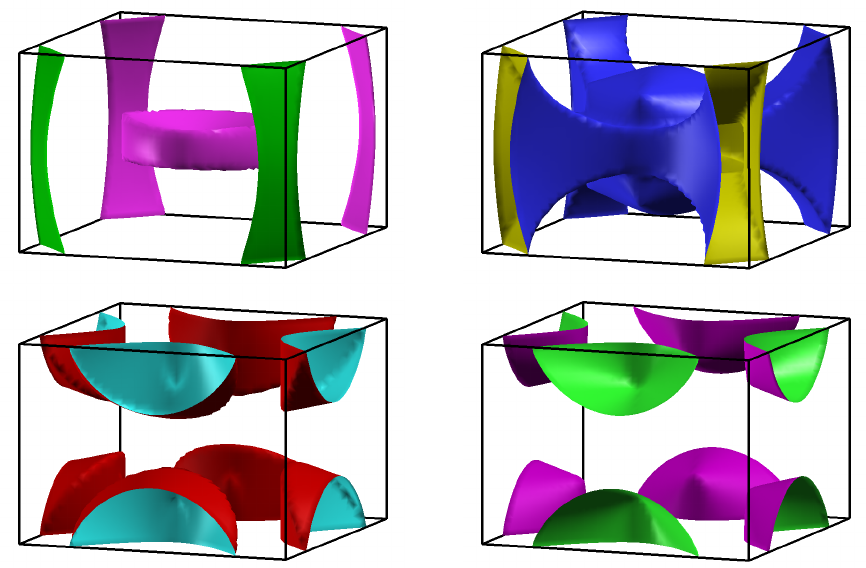
Figure 11: Calculated Fermi sheets of LaNiO netic Pnma